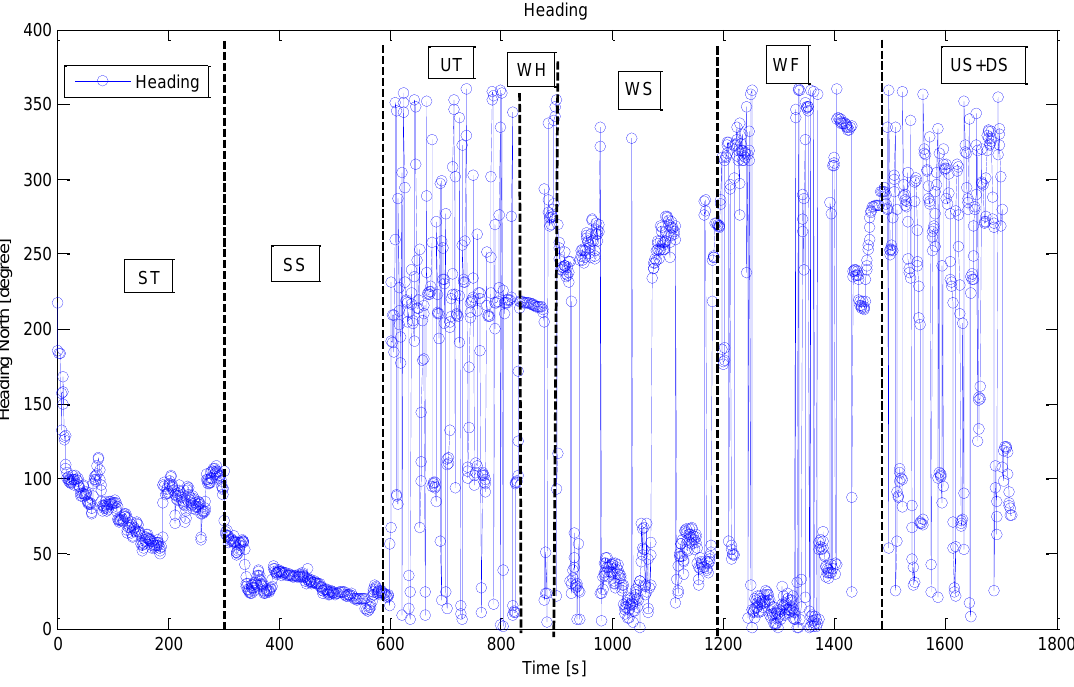
Figure 6. Magnetometer